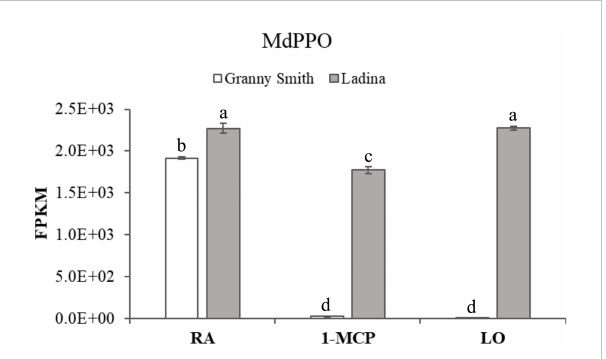
FIGURE 6 Polyphenol oxidase (PPO) expression level in ‘ Granny Smith ’ and ‘ Ladina ’ apple cultivars. The error bars correspond to the standard deviation. RA, Regular Atmosphere; 1-MCP, Regular Atmosphere + 1-MCP treatment; LO, Low Oxygen condition. FPKM, fragments per kilobase of transcript per million fragments mapped. Different letters indicate difference statistically signi fi cant according to Fisher ’ s least signi fi cant difference (LSD) test, p-value ≤